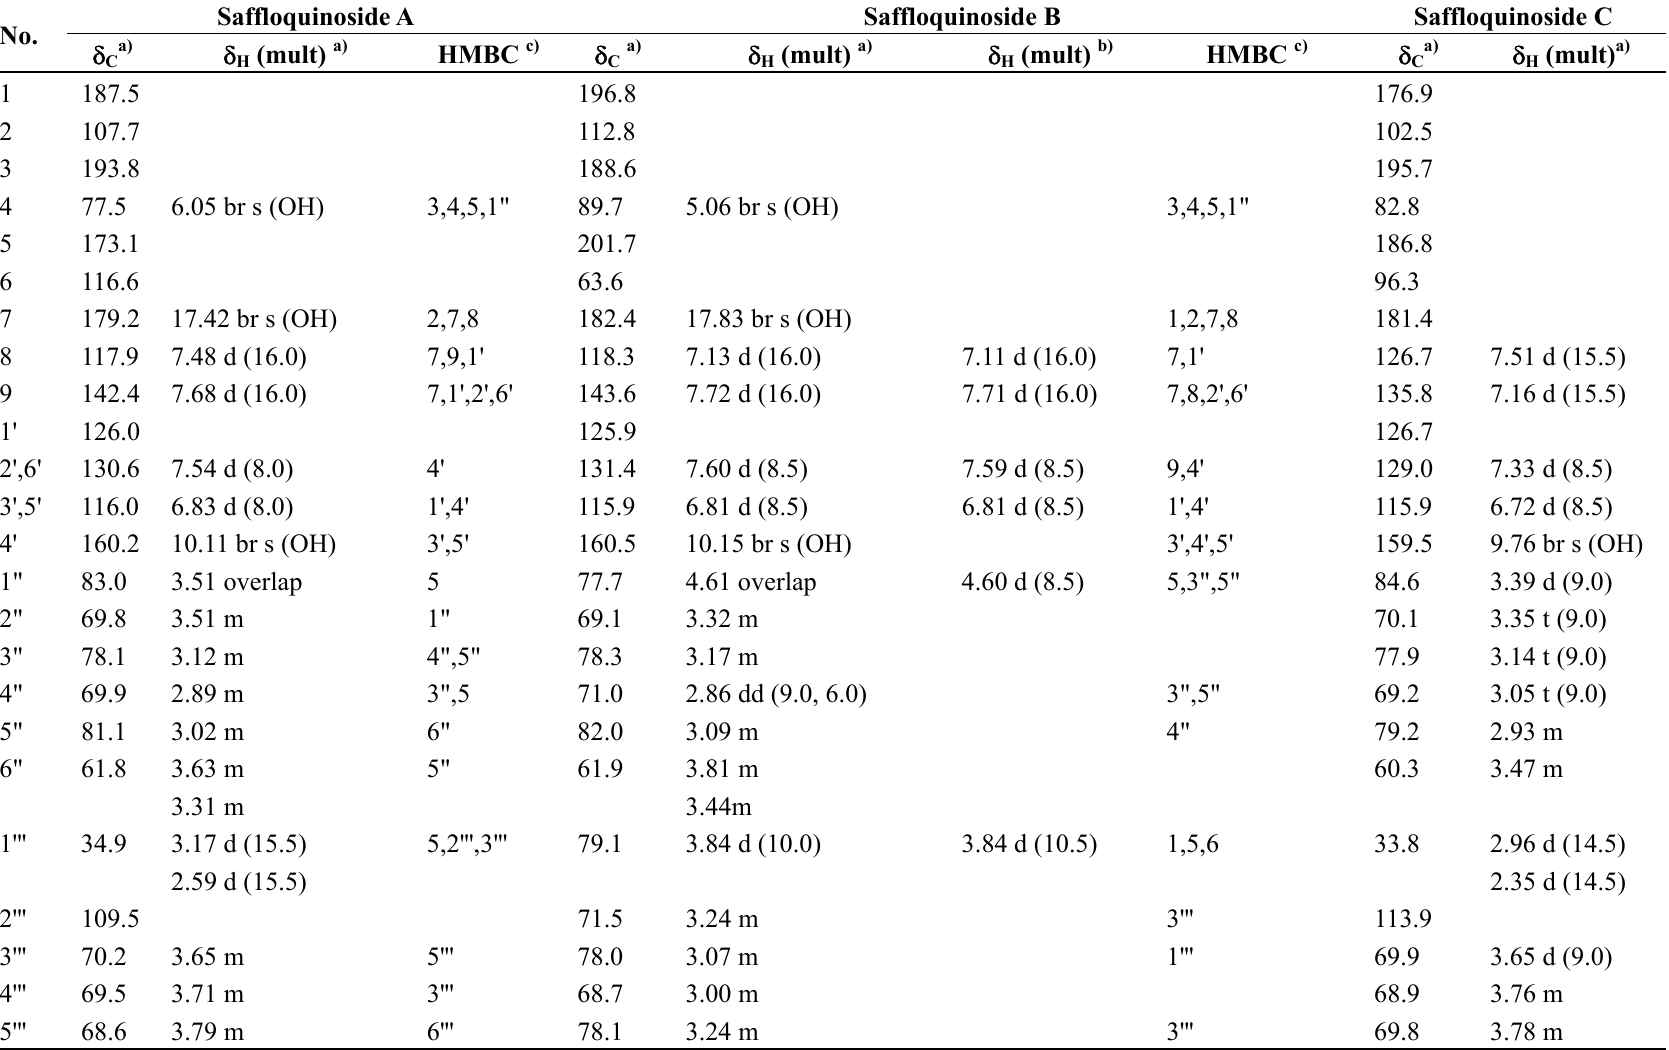
Table 14. NMR data for saffloquinoside A, saffloquinoside B, and saffloquioside